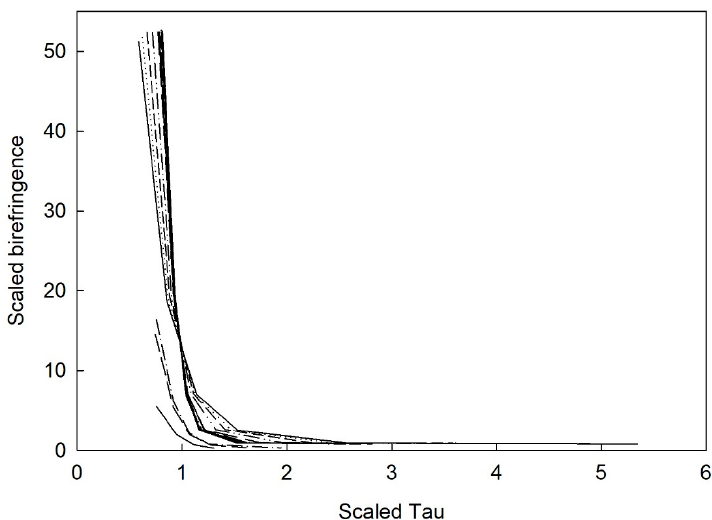
Figure 12. Schematic representation of scaled the birefringence data versus time to characterize the performance of the biosensor in a wide range of anchoring energy and surface viscosity.